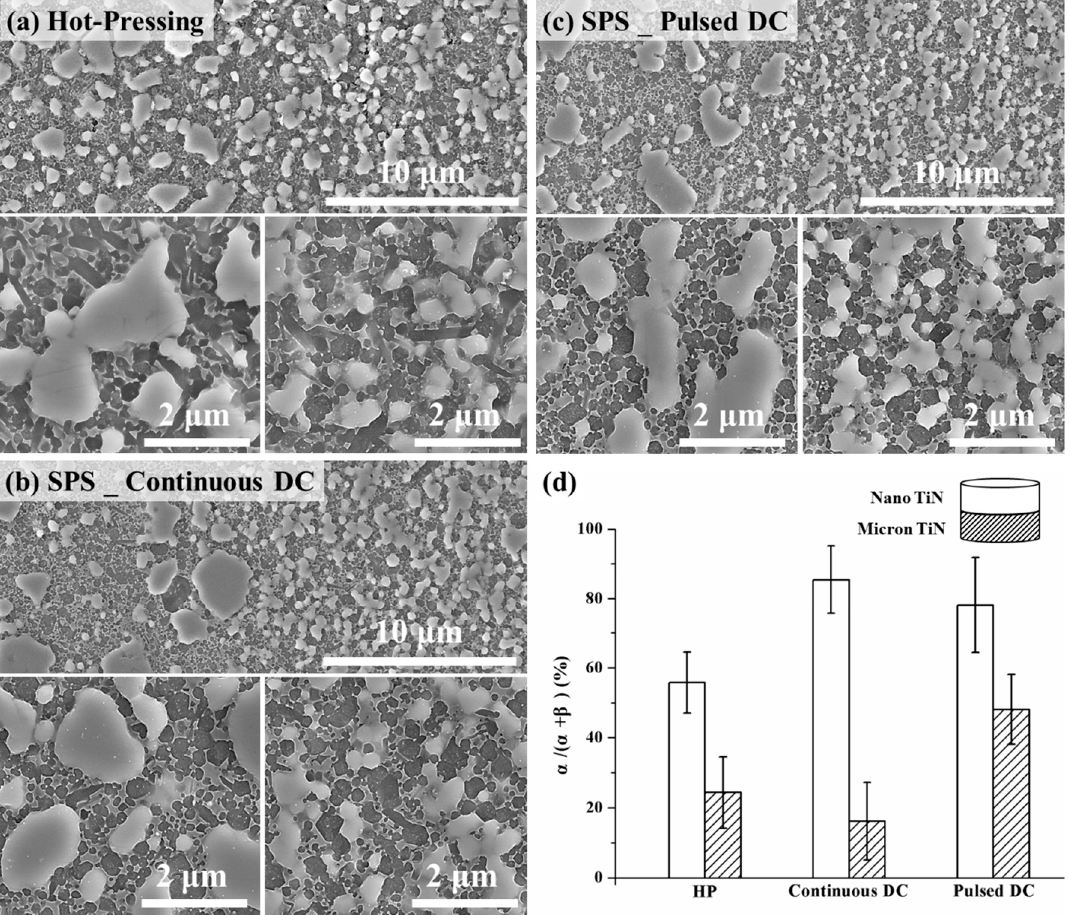
Figure 8. Low (upper side, including the layer interface) and high (underside) magnification cross-section views of the double-layered Si 3 N 4 -30 vol % TiN composites, prepared at 1700 ◦ C for 5 min with nano- and micron-TiN, by using ( a ) hot-pressing, ( b ) SPS continuous mode, and ( c ) SPS pulsed mode; and ( d ) the α -Si 3 N 4 fraction within each layer.